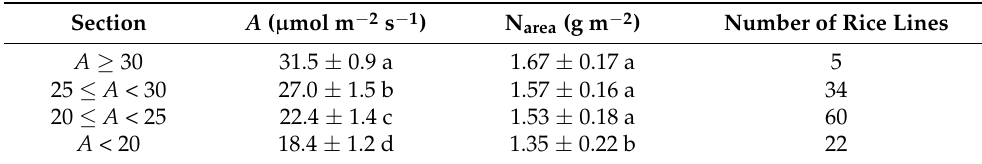
Table 1. The average leaf net photosynthetic rate ( A ) and area-based leaf nitrogen content (N area ) of 121 cultivated rice lines in different sections.